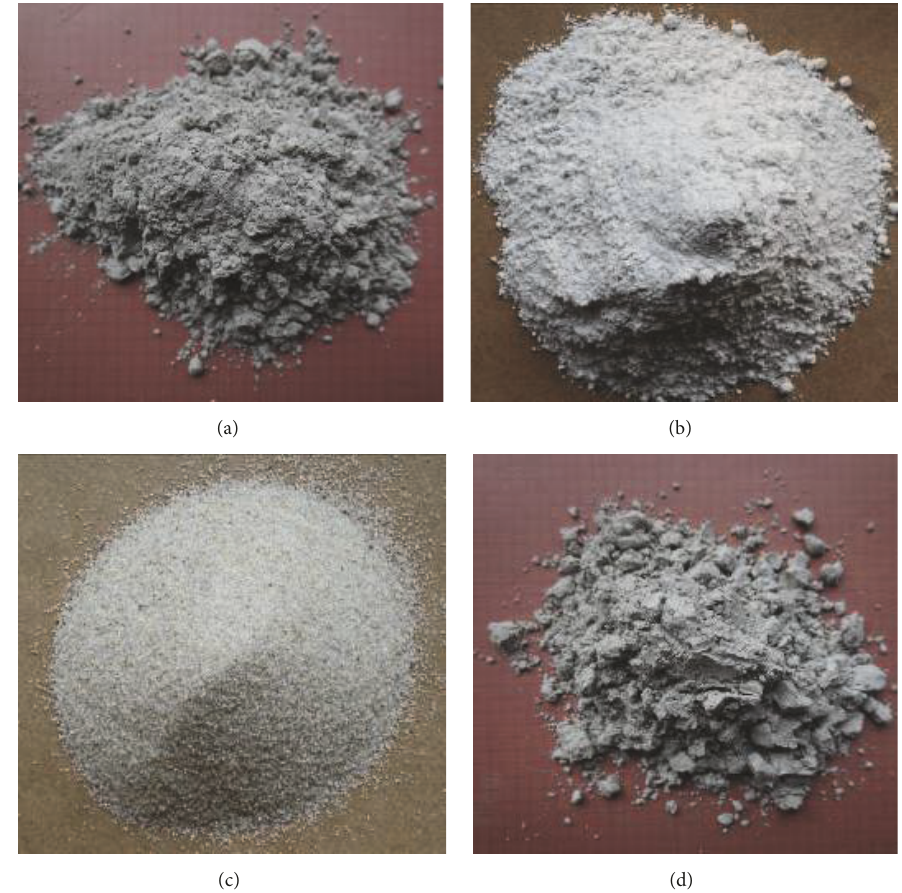
Figure 1: Constituents of simulated soft rocks: (a) cement; (b) plaster; (c) medium sand; (d) concrete-hardening accelerator.